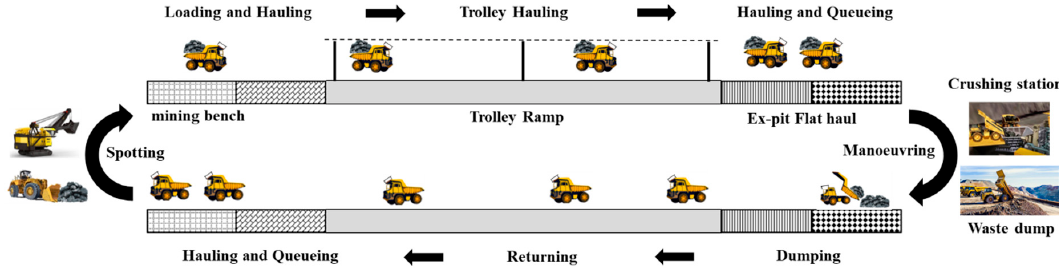
Figure 13. A schematic of dynamic charging BT systems operational process.